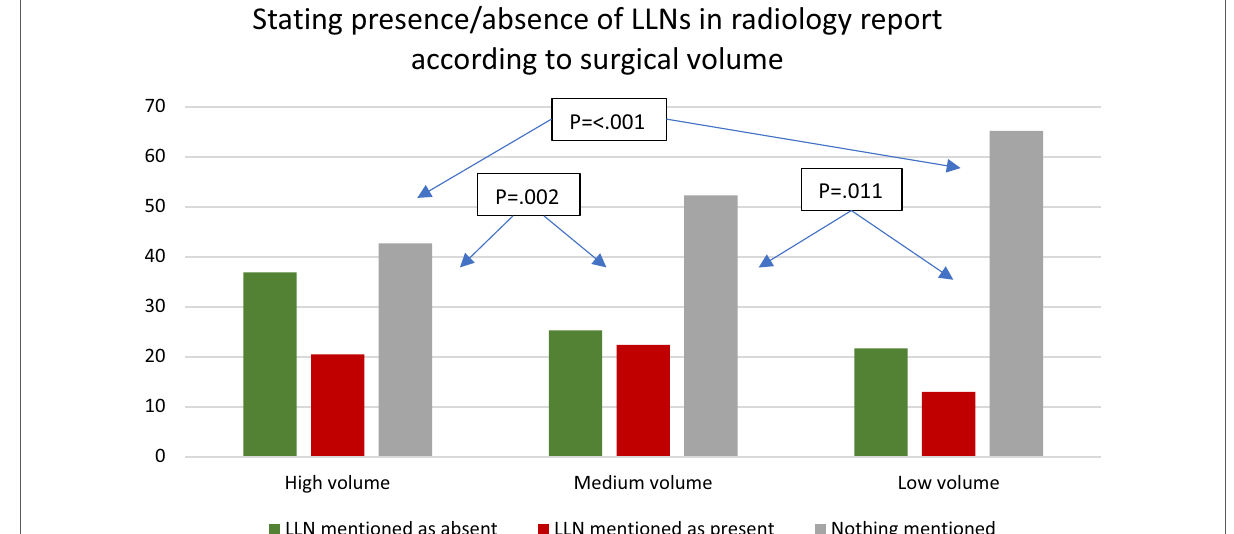
Fig. 4 Stating the presence or absence of LLNs in primary MRI reports according to surgical volume of rectal resections per year. High volume: 60 rectal resections or more, medium volume: 30–59 resections, low volume: 0–29 resections (based on the number of resections according to part 1 of this Snapshot study for